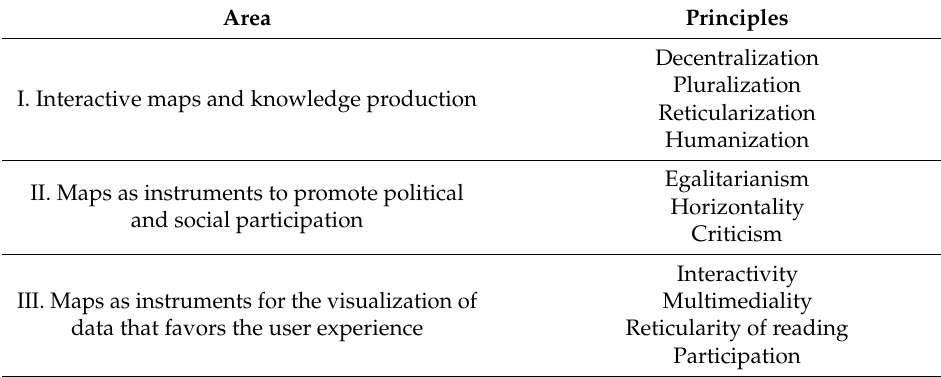
Table 1. Structure of the theoretical-conceptual